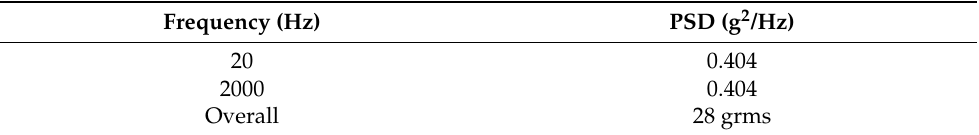
Table 10. Specification of random vibration [10].